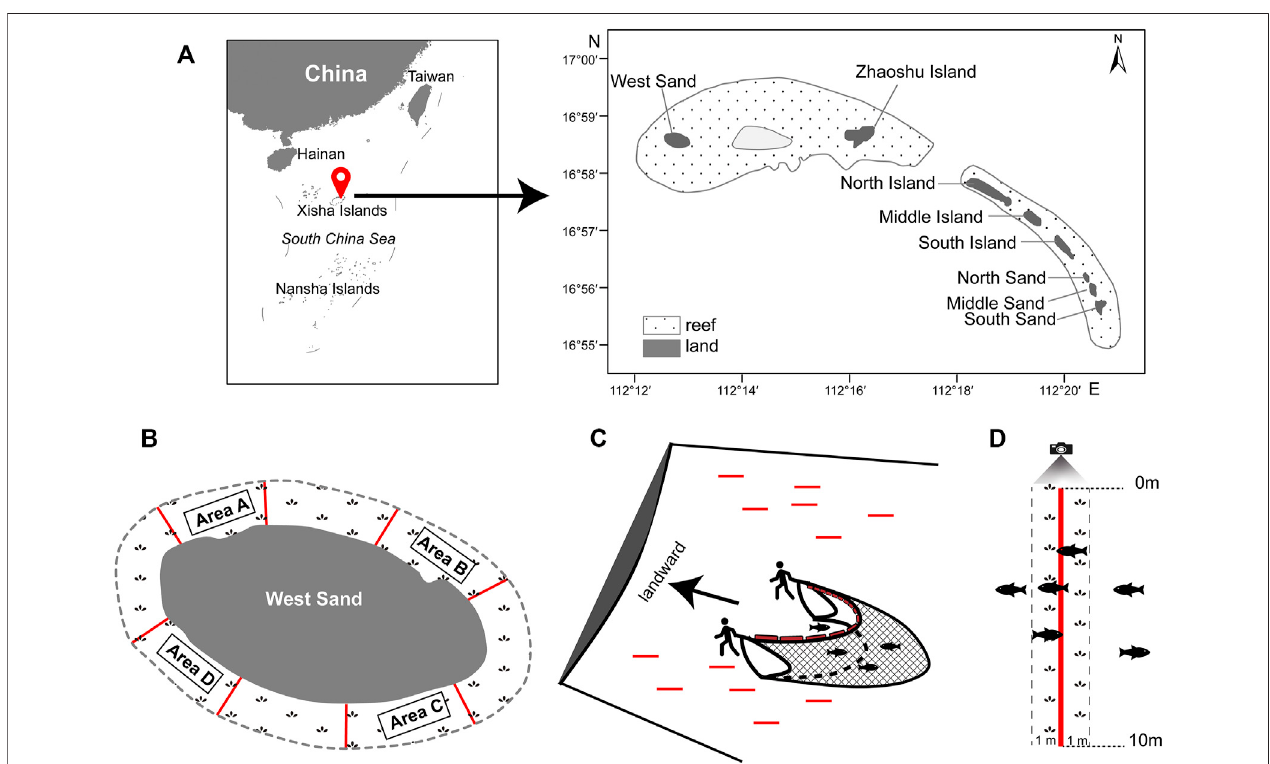
FIGURE1|(A) LocationoftheQilianyucluster(redballoon),XishaIslands,SouthChinaSea. (B) ThefoursurveyareasA – DatWestSand. (C) Beachseinemethod (BS).Redlinesindicatethe12random20-mlinetransectsinasurveyarea. (D) Linetransect-basedunderwatervisualcensusmethod(UVC).Theredlineindicatesoneof the fourteen 10-m line transects in a survey